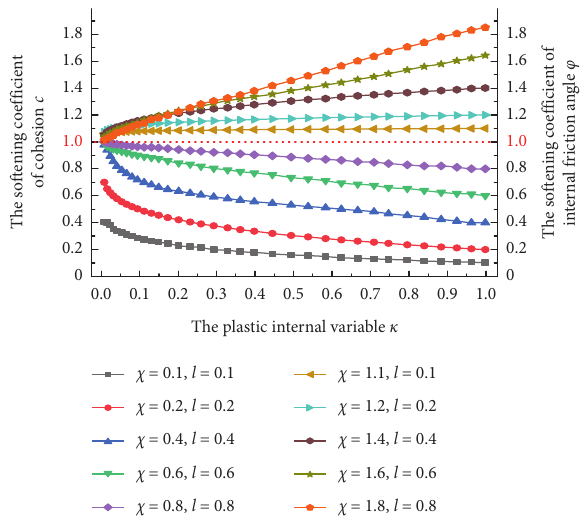
Figure 10: Evolutionary curve of Γ of roadway surrounding